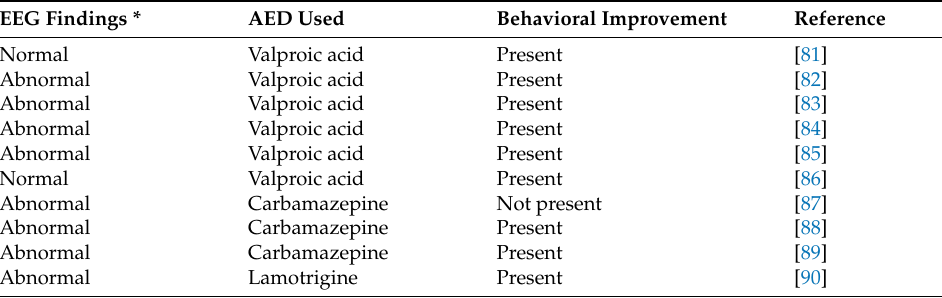
Table 2. Role of electroencephalography (EEG) and antiepileptic drugs (AEDs) in